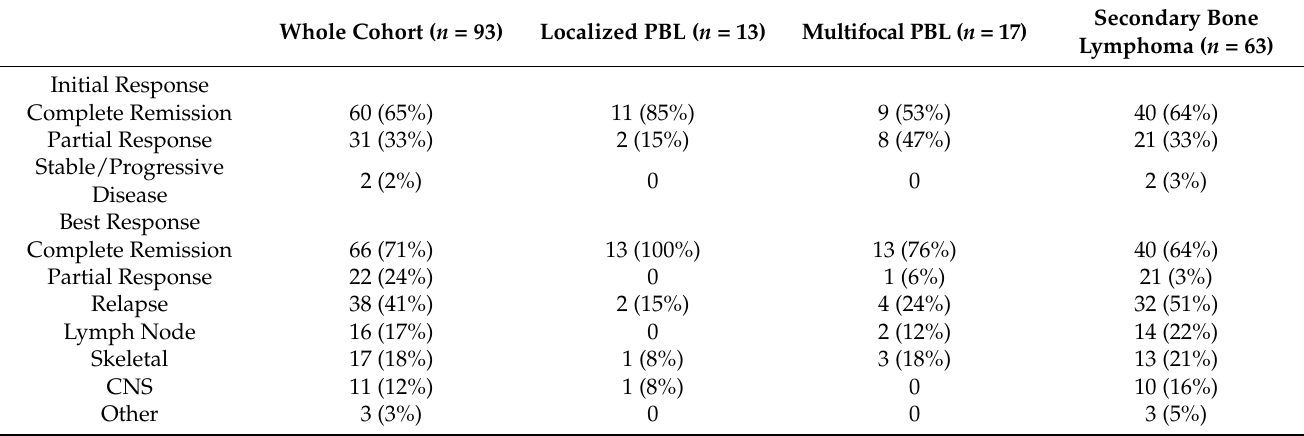
Table 2. Outcome of